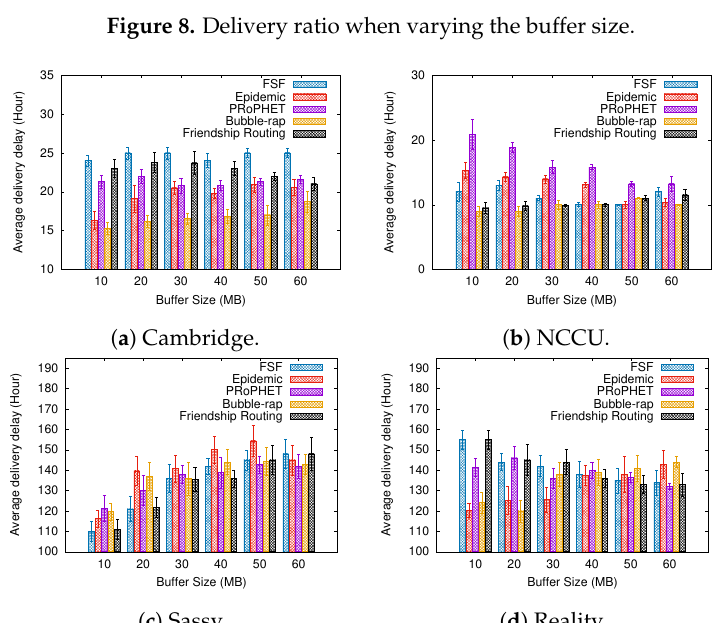
Figure 9. Delivery delay when varying the buffer